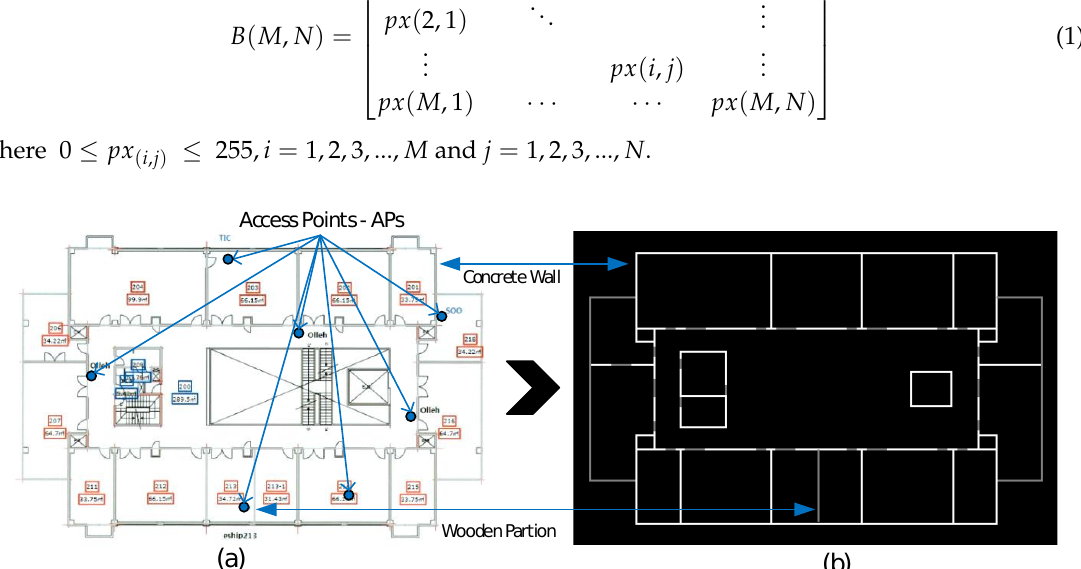
Figure 2. Input: ( a ) detailed floor plan of the Regional Innovation Center (RIC Building) and ( b ) corresponding output: Wall-map obtained from the pixel map tracing